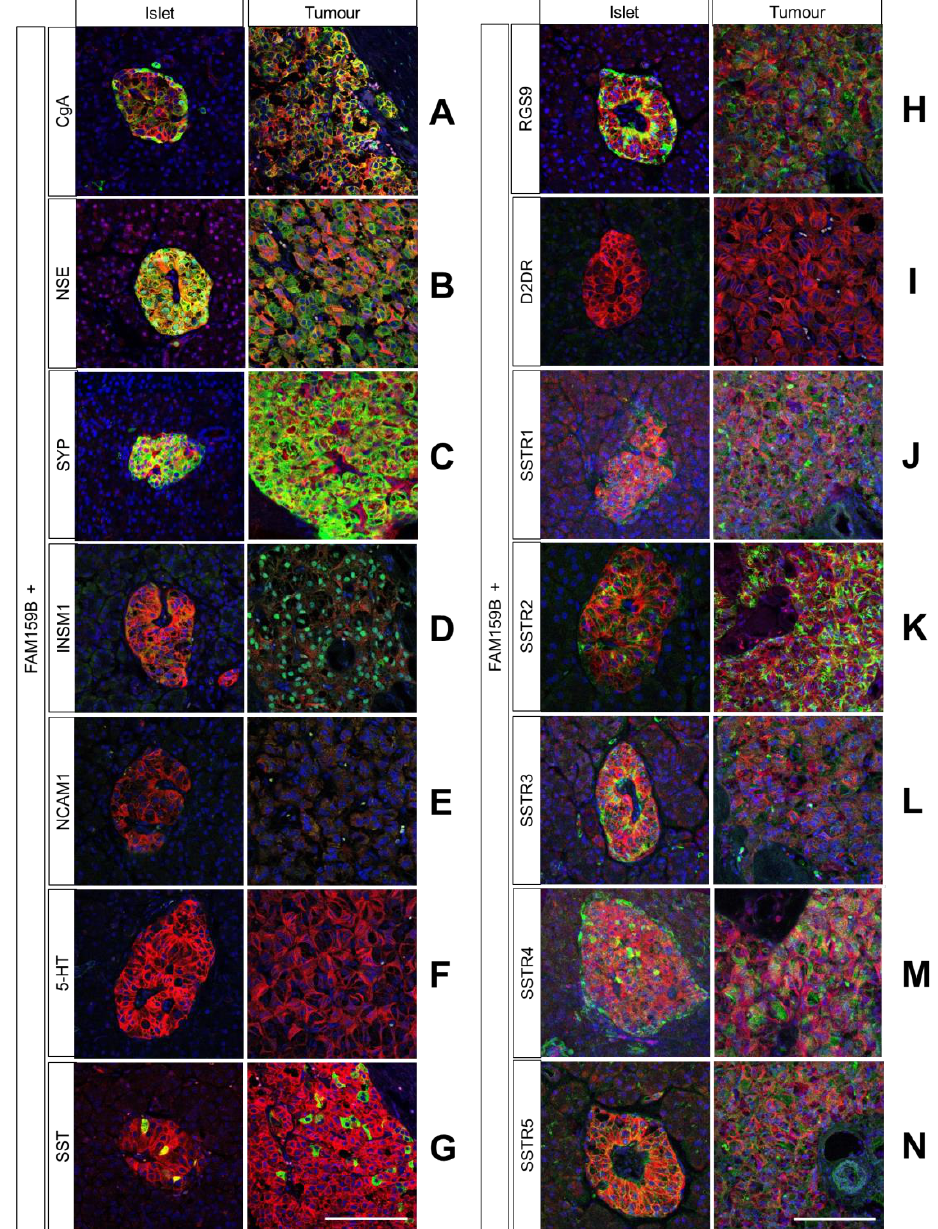
Figure 5. Double-labelling immunohistochemical analysis of FAM159B and chromogranin A (CgA; A ), neuron specific enolase (NSE; B ), synaptophysin (SYP; C ), insulinoma-associated protein 1 (INSM1; D ), neural cell adhesion molecule 1 (NCAM1; E ), serotonin (5-HT; F ), somatostatin-14/28 (SST; G ), regulator of G-protein signalling (RGS9; H ), dopamine receptor 2 (D2R; I ), somatostatin receptor 1 (SSTR1; J ), somatostatin receptor 2 (SSTR2; K ), somatostatin receptor 3 (SSTR3; L ), somatostatin receptor 4 (SSTR4; M ), or somatostatin receptor 5 (SSTR5; N ) expression in human pancreas or pancreatic neuroendocrine tumour tissues. Sections were dewaxed, microwaved in citric acid and incubated with corresponding primary antibodies. Labelling for FAM159B was